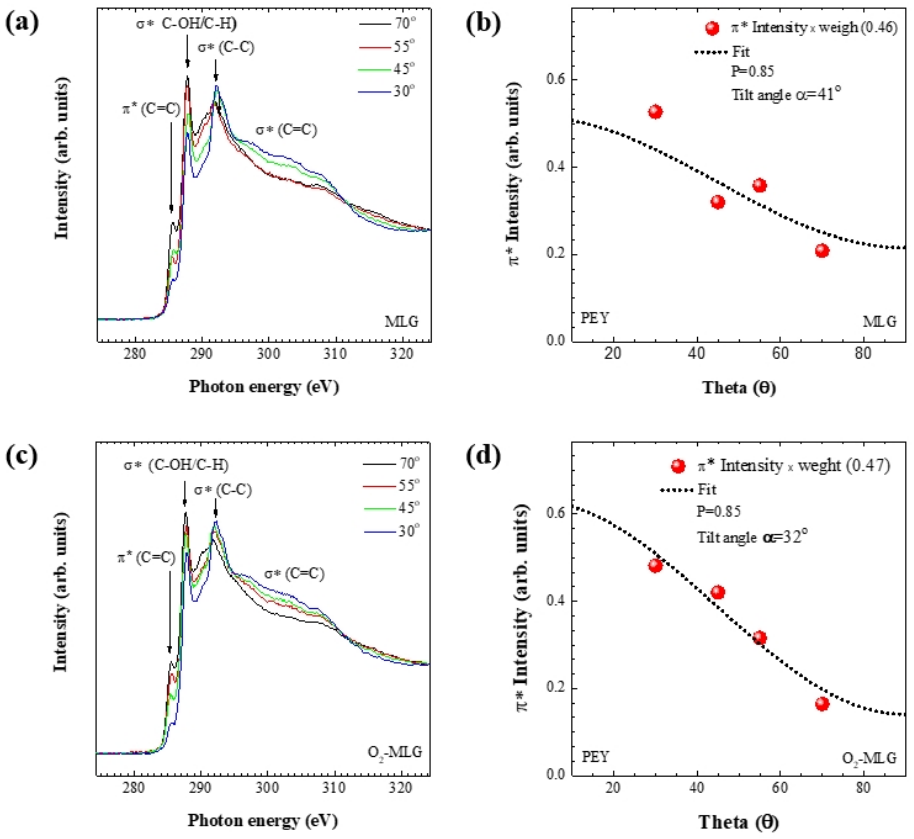
Figure 4. Angle-reserved carbon K-edge NEXAFS spectra of ( a ) MLG and ( c ) O 2 -MLG samples. The Figure 4. Angle ‐ reserved carbon K ‐ edge NEXAFS spectra of ( a ) MLG and ( c ) O 2 ‐ MLG samples. The calculated molecular average tilt angles of ( b ) MLG and ( d ) O 2 -MLG samples, using the Fermi golden calculated molecular average tilt angles of ( b ) MLG and ( d ) O 2 ‐ MLG samples, using the Fermi golden rule equation. rule